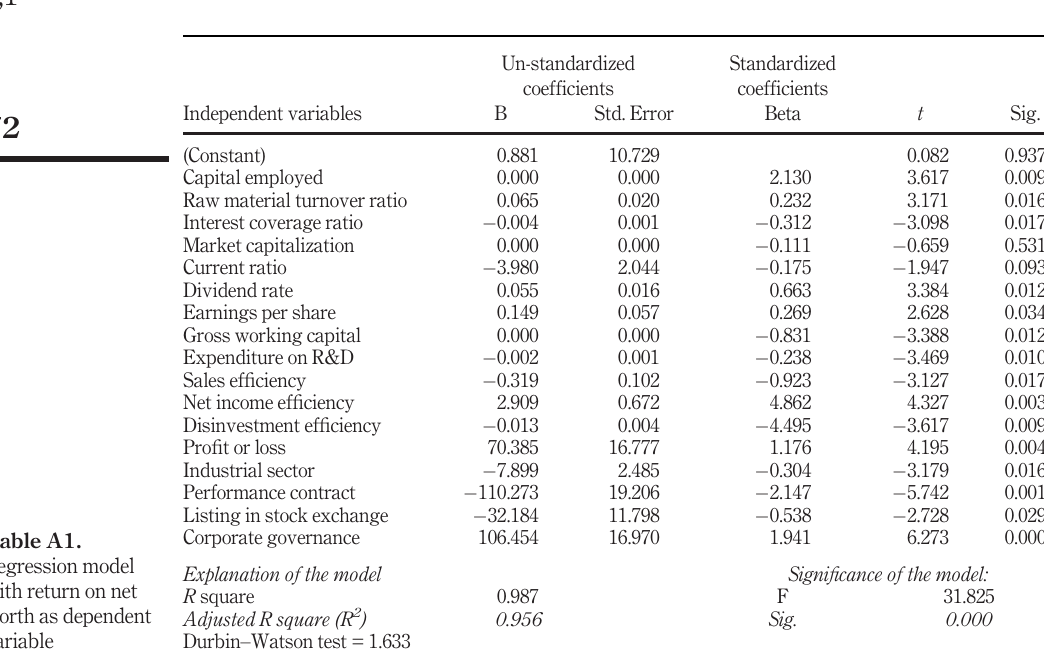
Table A1. Regression model with return on net worth as